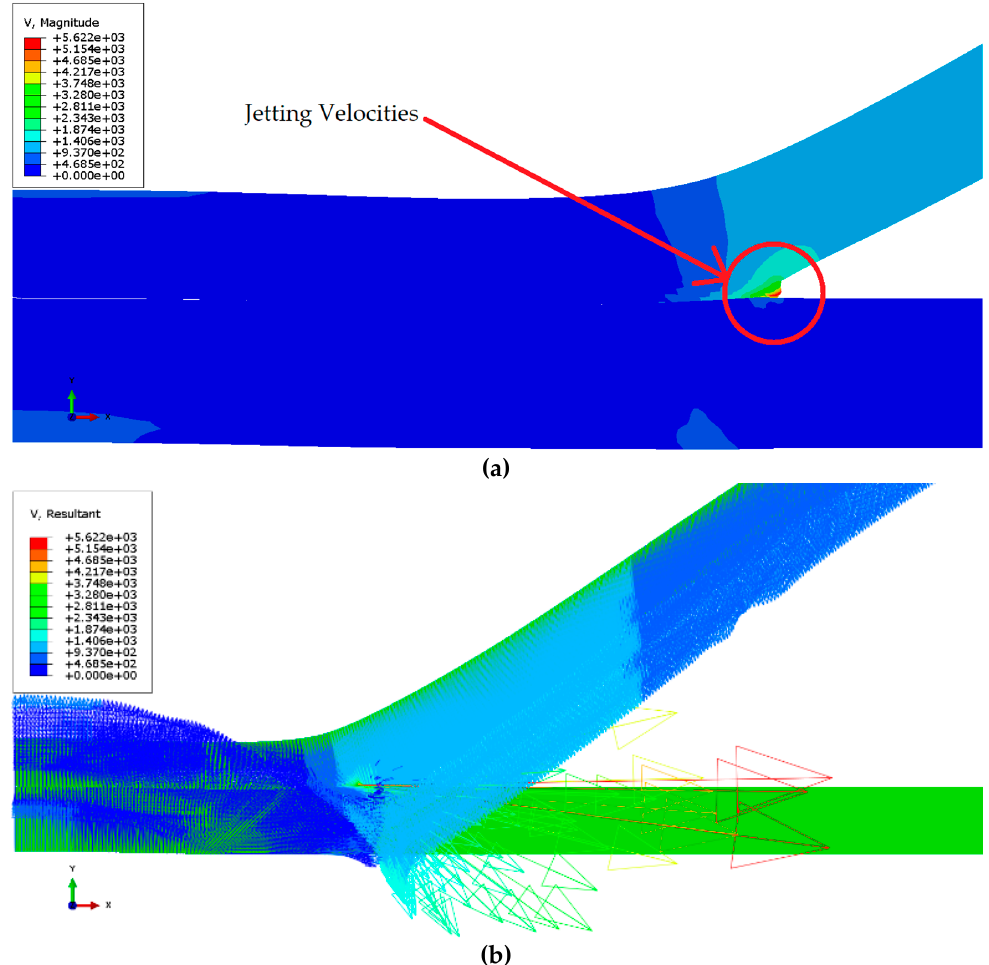
Figure 15. Axisymmetric simulation results: velocity (m/s) contour plot and deformed shape at different times during the collision.